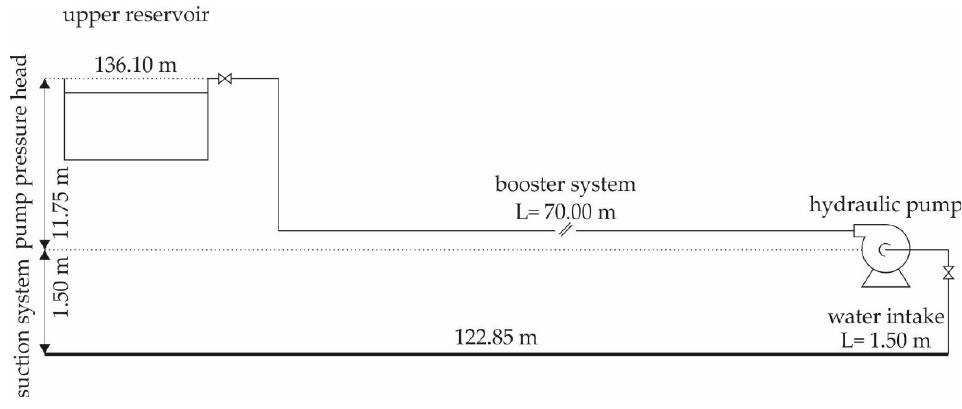
Figure 3. Simplified model of the pumping system of the Elevated Pumping Station II, Rio Branco, Acre.